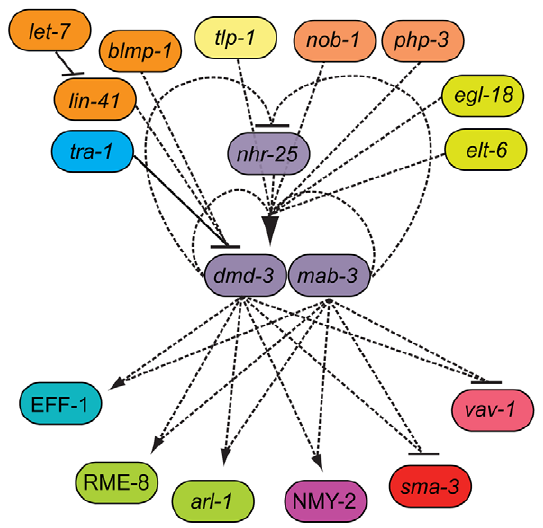
Figure 8. The genetic architecture of tail tip morphogenesis, showing experimentally validated connections between com- ponents. This network has a bow-tie architecture with dmd-3, mab-3 and nhr-25 in the core. The central role for dmd-3 and mab-3 was originally proposed by Mason et al. [7]. We found that nhr-25 is required for the activation of dmd-3 and forms a negative feedback loop with dmd-3 and mab-3. Multiple signaling pathways/genes feed into the core by regulating dmd-3 positively (lines with arrow at one end) or negatively (lines with bar at one end). Genes controlling morphogenesis ( rme-8 , nmy-2 , arl-1 , eff-1 ) and other signaling pathways (TGF- b and vav- 1 -mediated) are regulated by dmd-3 and mab-3. Dashed lines indicate possibly direct or indirect interactions, solid lines indicate an experimentally validated direct interactions [7].